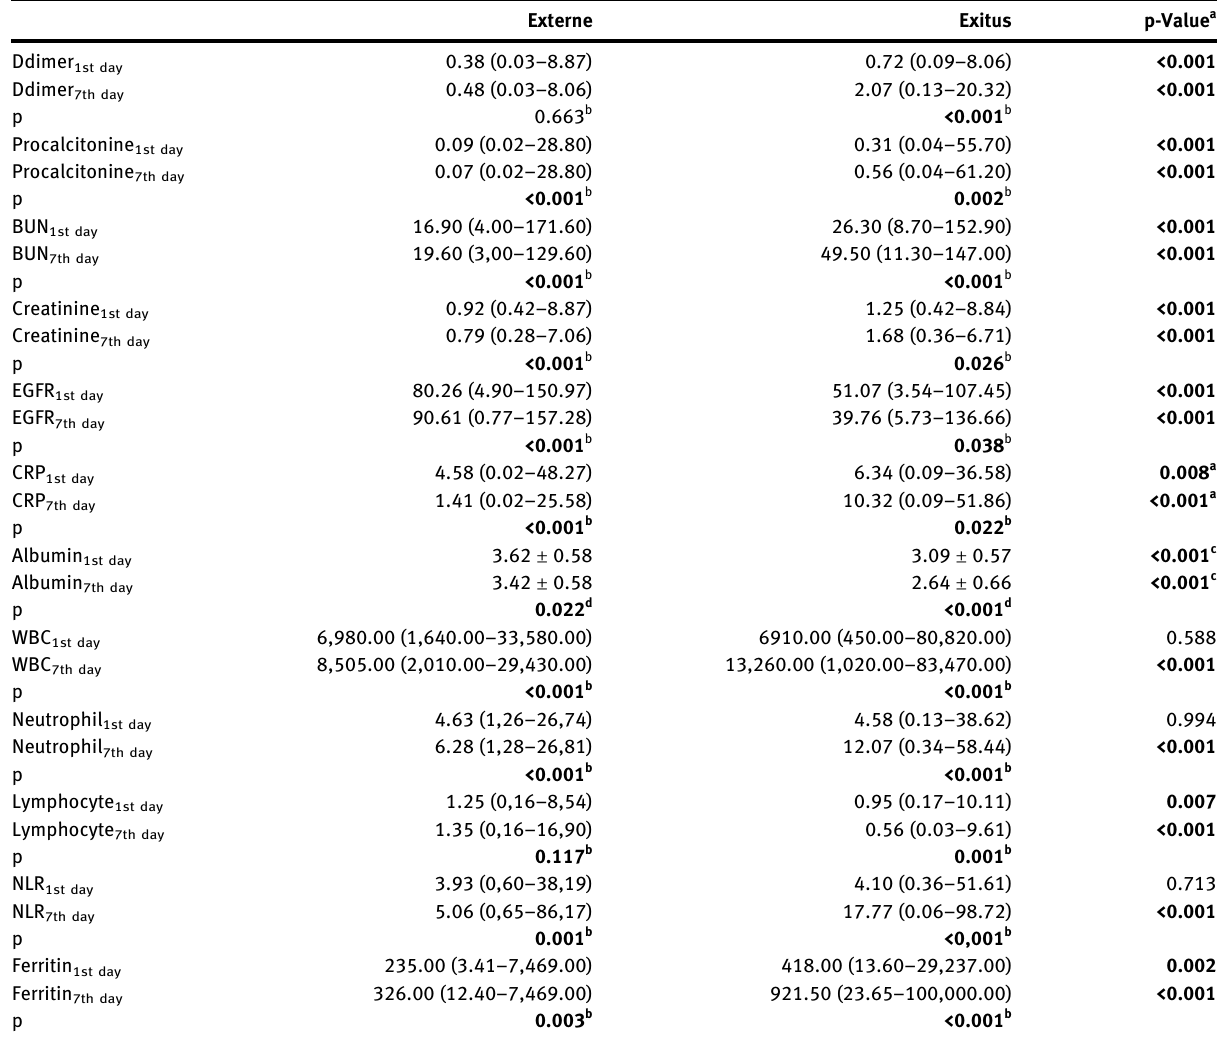
Bold values indicate statistically significant (p<  .  ). a Mann-Whitney U test statistic, b Wilcoxon test statistic, mean. (min – max), c two independent samples t-test statistics, d paired two sample t-test